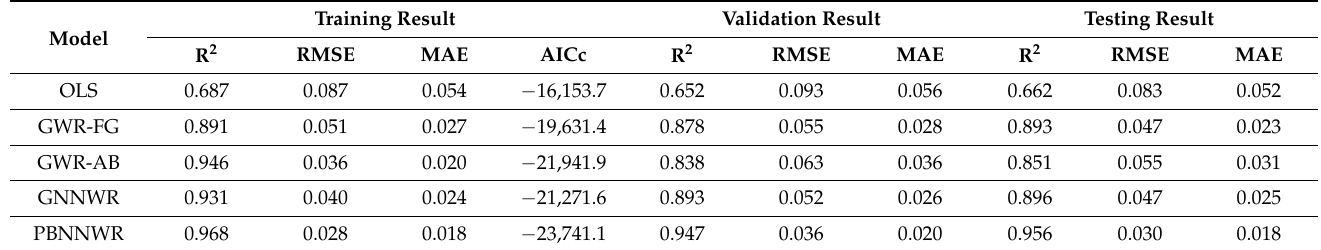
Table 5. Statistics of the different modeling results on